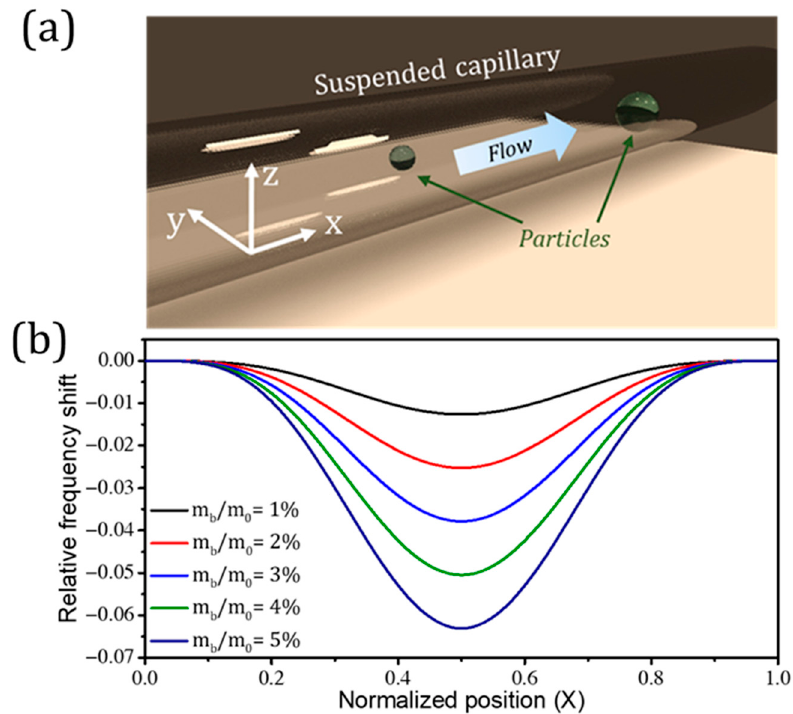
Figure 8. ( a ) Schematic depiction of a hollow transparent suspended capillary with flowing particles inside. ( b ) Theoretical prediction of the relative frequency shift for the first mode of the capillary for different masses as a function of the position.